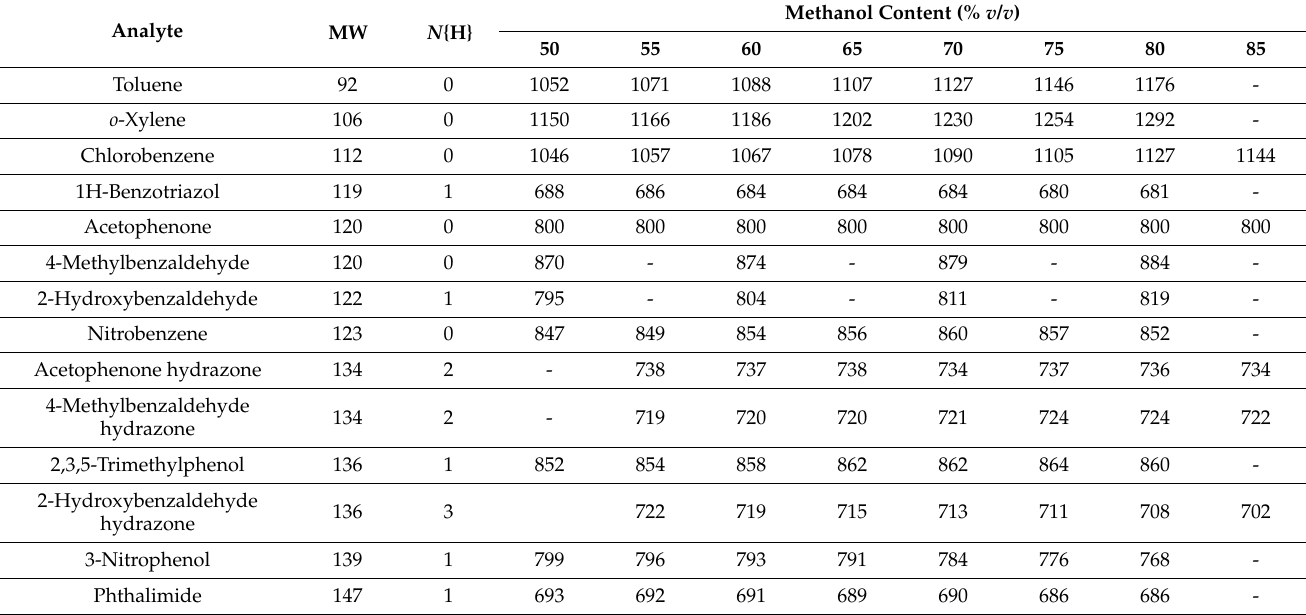
Table 2. Retention indices of some organic compounds, depending on the methanol content in the